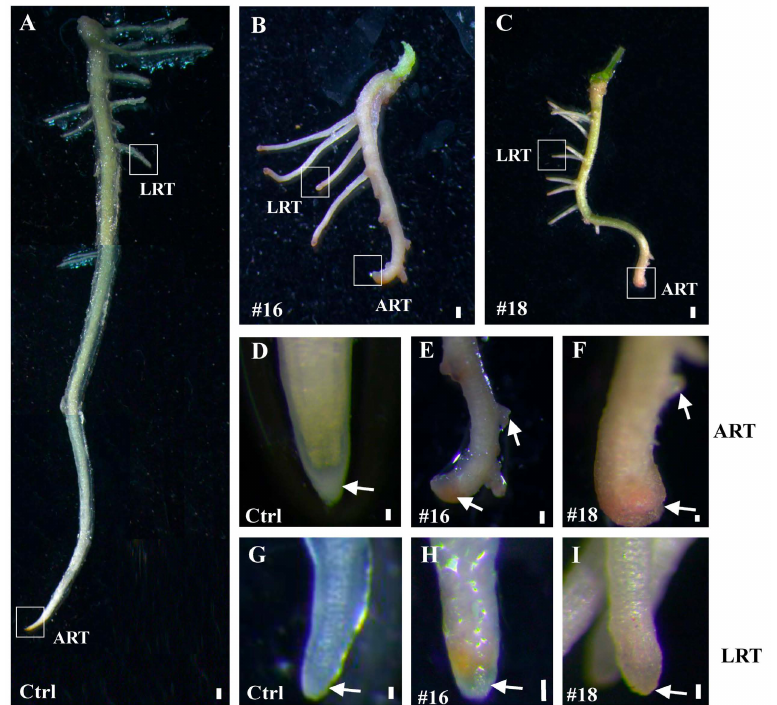
Figure 7. Root morphology of Ctrl and PtoWUSa- overexpressing poplar plants. ( A – C ) ARs of Ctrl and transgenic plants. ( D , F ) Close-up views of ARTs of Ctrl and transgenic plants from ( A – C ). ( G – I ) Close-up views of LRTs of Ctrl and transgenic plants from ( A–C ). Scale bars: ( A – C ) = 1 mm; ( D , F – I ) = 1 µ m; ( E ) = 3 µ